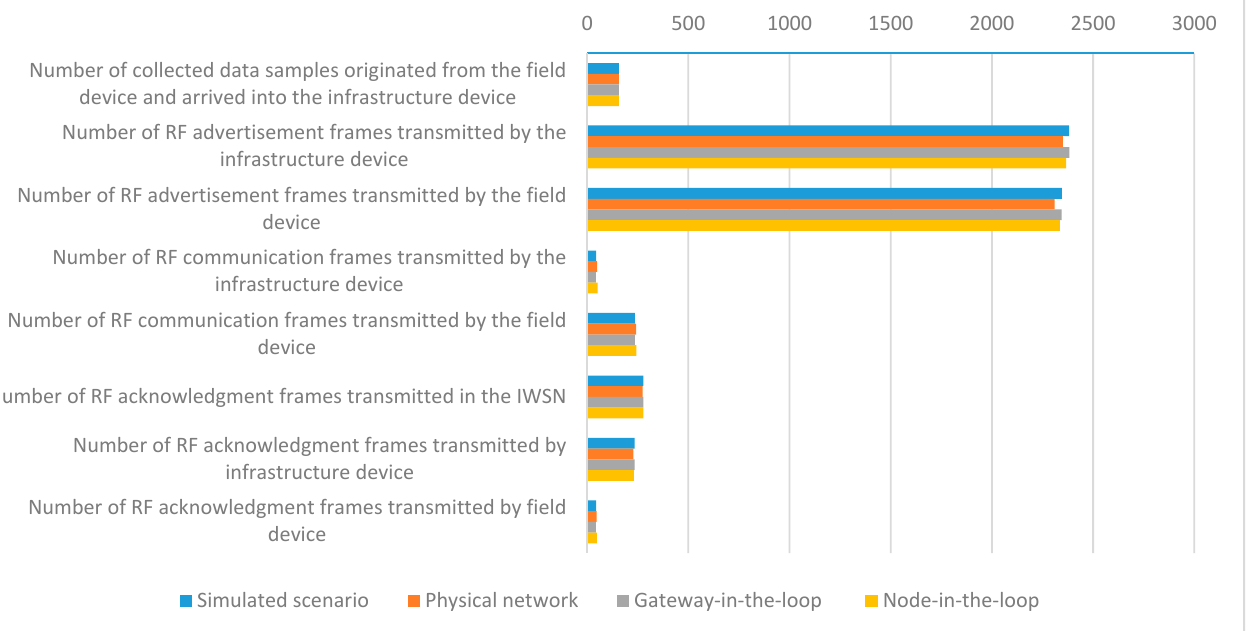
Figure 12. Mean values of the communication statistics metrics.